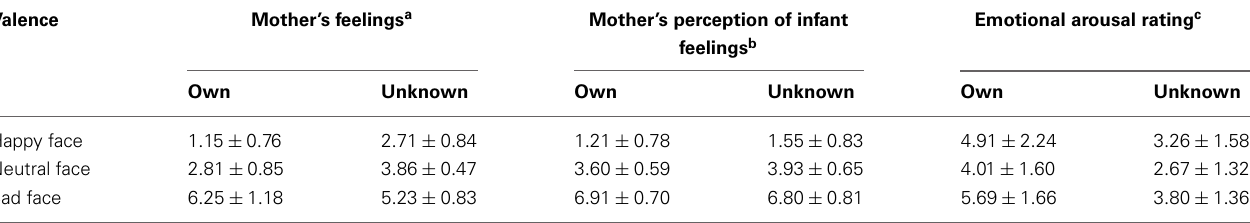
Table 1 | Mothers’ self-reported ratings ( M ± SD ) of infant face stimuli (own and unknown).